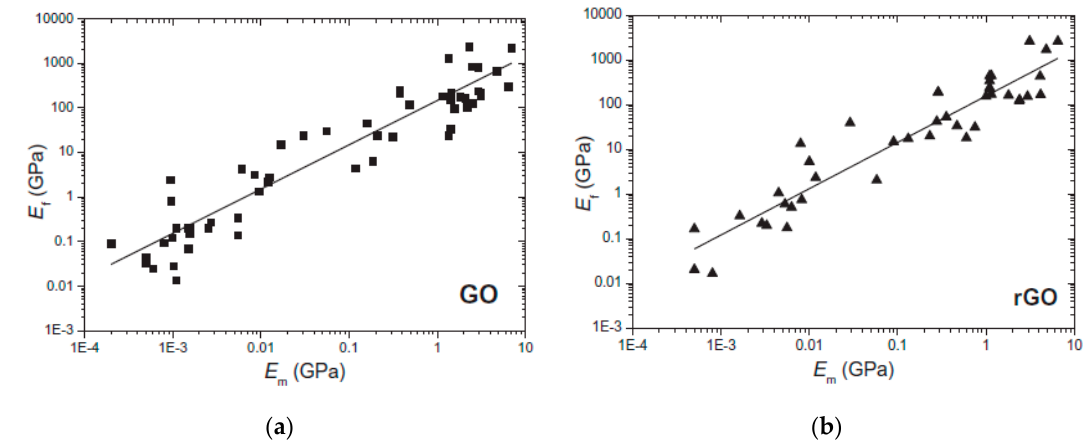
Figure 3. Young’s modulus (E f ) of graphene-based materials as a function of the modulus of the matrix (E m ): ( a ) graphene oxide (GO); ( b ) reduced graphene oxide (rGO). Adapted from [114].